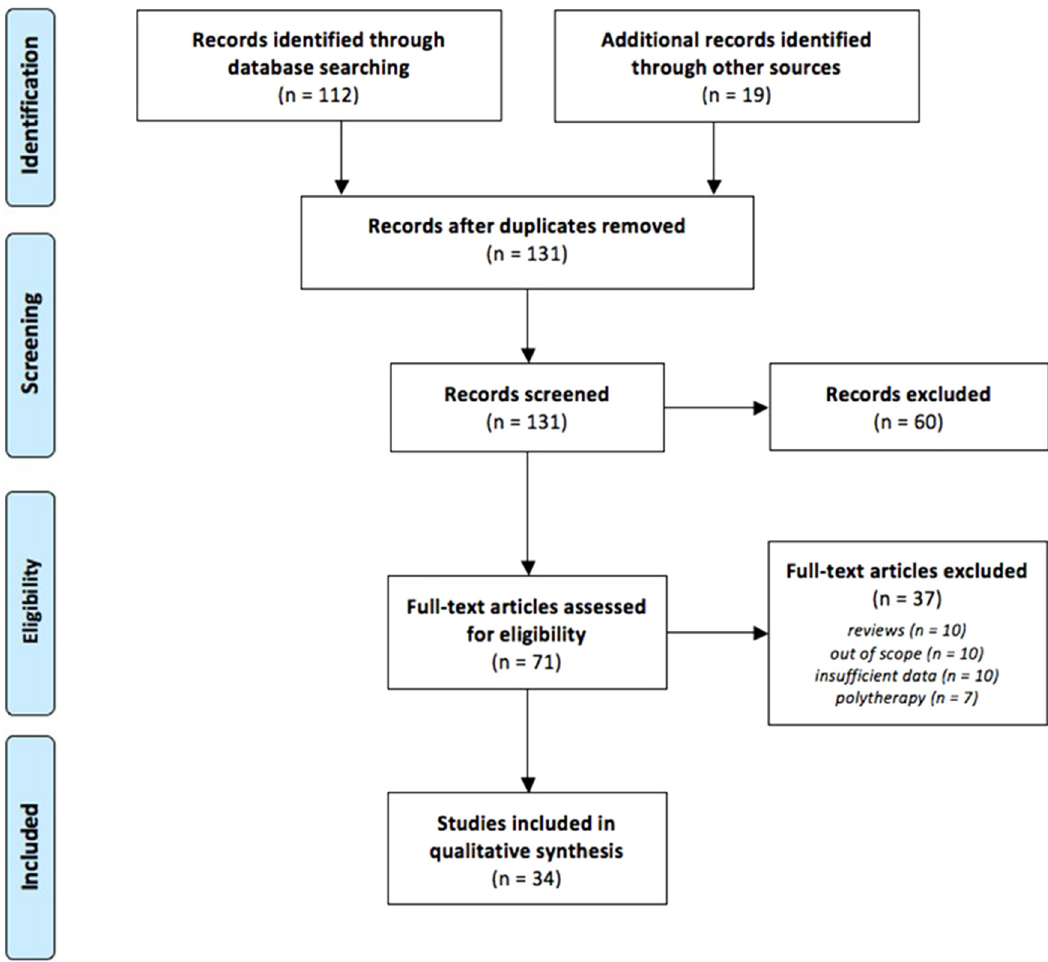
Fig. 1. Study fl owchart (following PRISMA-ScR